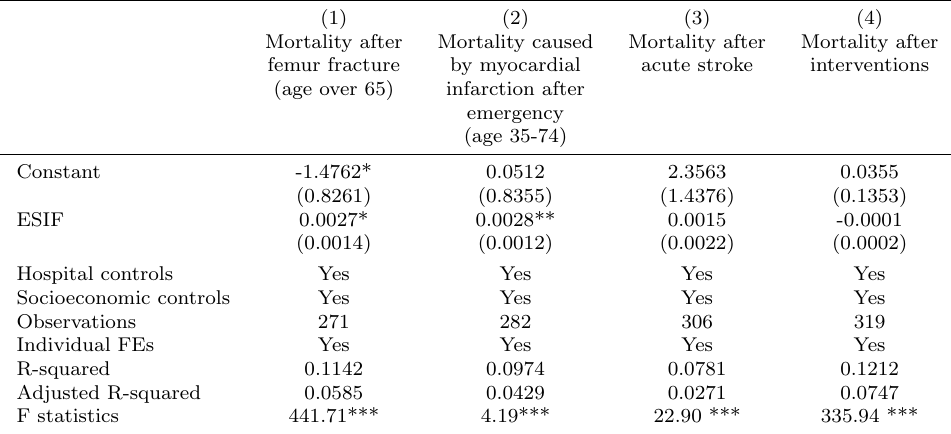
Table 7: Contemporaneous effect of ESIF on the mortality rate in selected categories (part 2) (5) (6) (9) Mortality in Ratio of trans- Mortality in Pressure Operation ICUs fers to ICUs regular wards ulcer rate after a trans- fer from ICU Constant 0.3189 -5.3445* -0.0042 0.0107 -0.0014** -0.0072 Yes Yes Yes Yes Socioeconomic controls Yes Yes Yes Yes Yes Observations 220 220 221